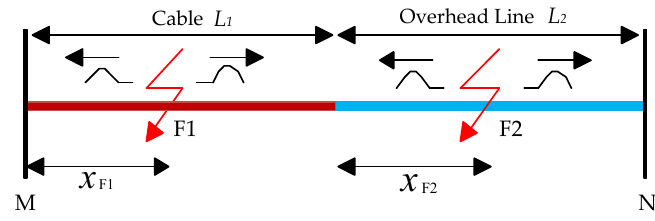
Figure 3. Fault occurrence at F1 and F2 at the cable and overhead lines.